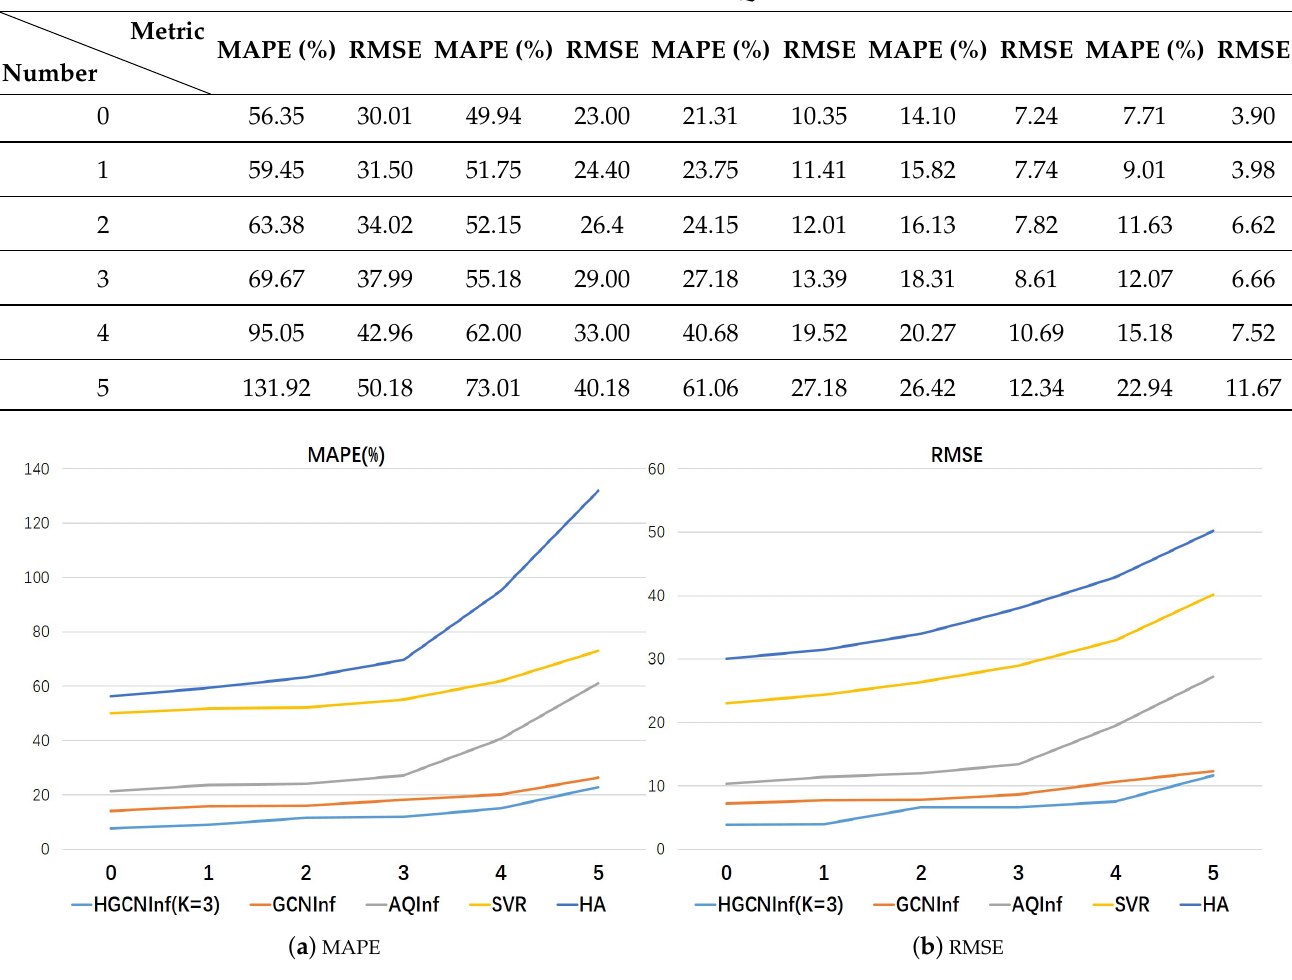
Figure 9. The robustness of each air-quality-inference model when gradually reducing the number of labeled